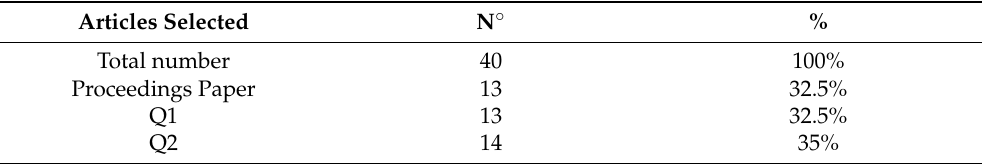
Table 2. Main data associated with the quality of the scientific journals in which the selected articles were published.